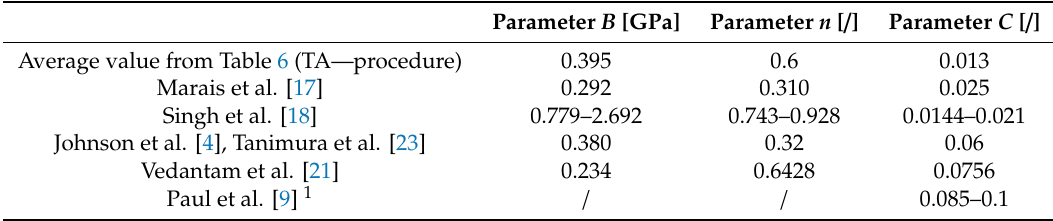
Table 11. Comparison with other parameter values in the